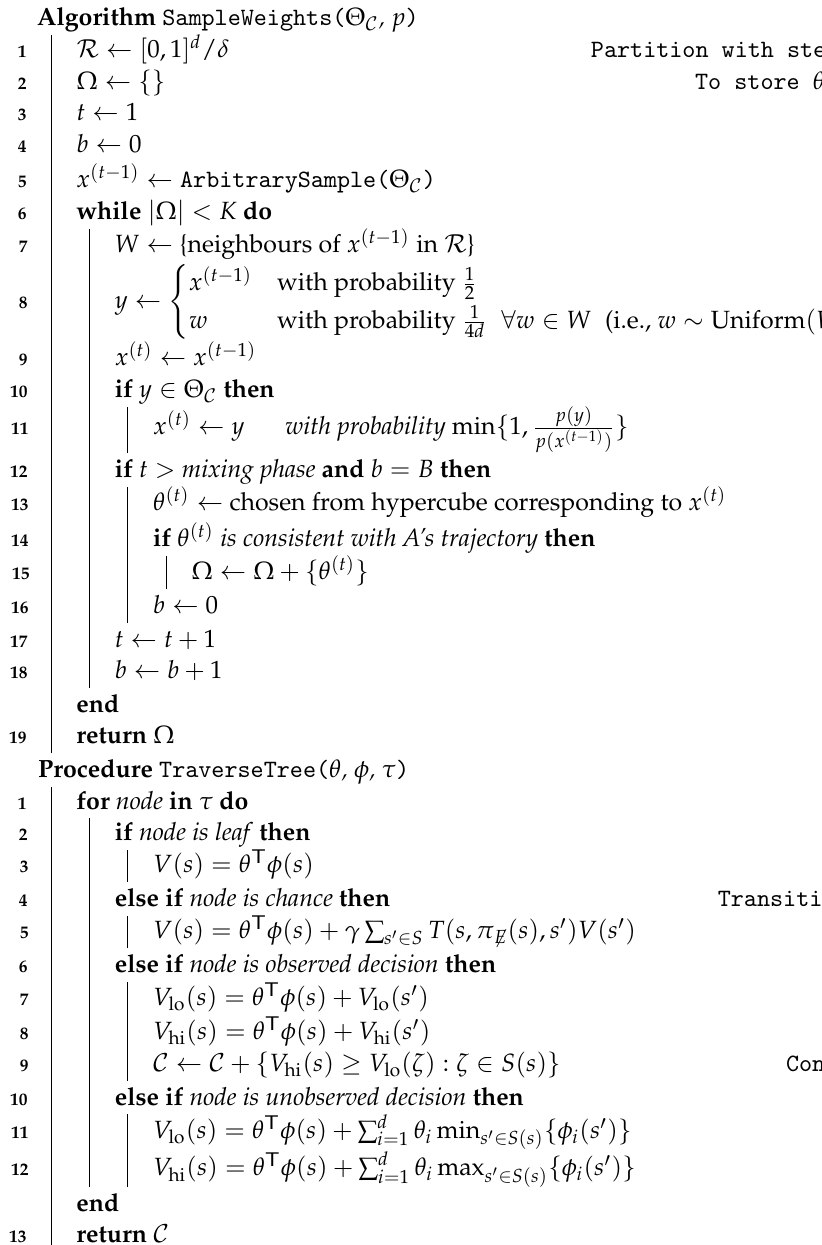
Algorithm 4: Metropolis–Hastings-based approach to approximate q ( θ | τ ) from [46] . Algorithm SampleWeights( Θ C , p